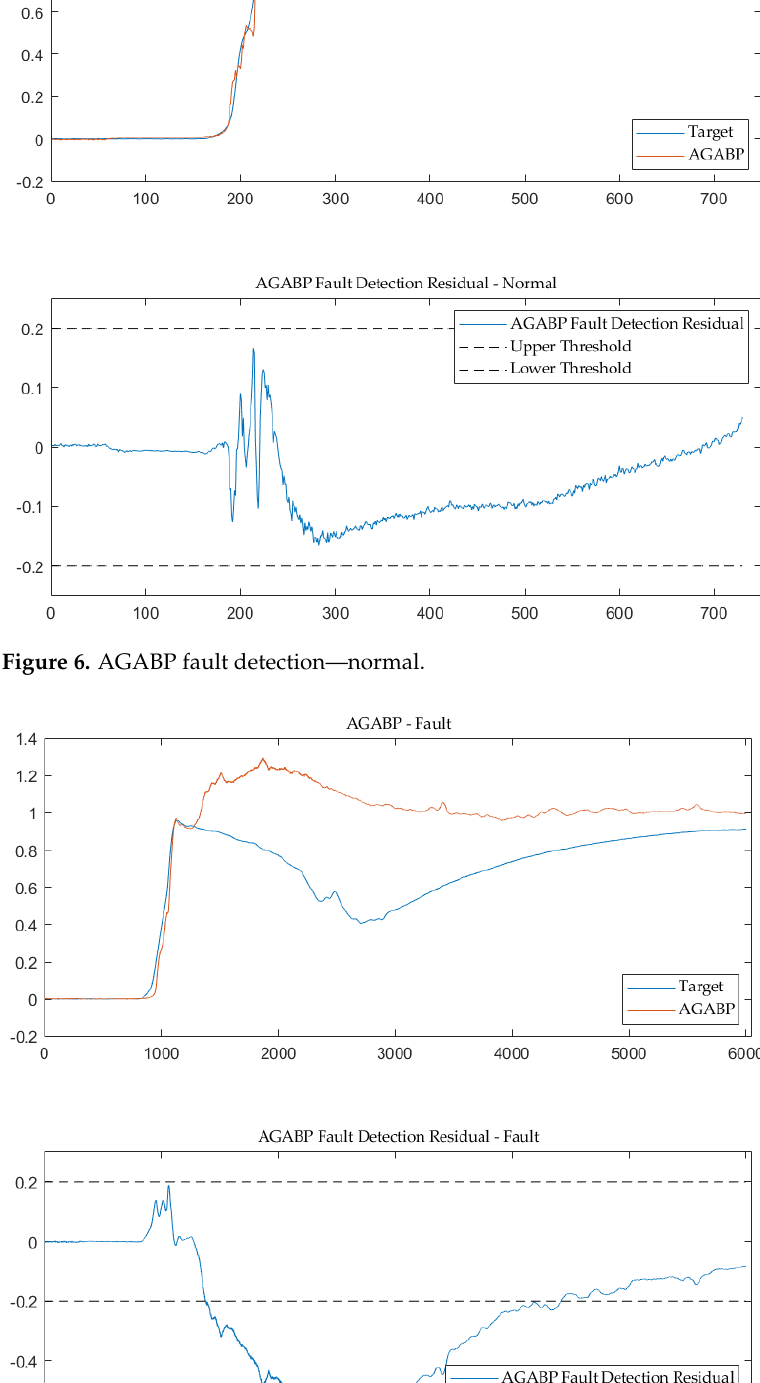
Figure 7. AGABP fault detection—fault. 5.2. Simulation Result and Analysis In order to evaluate the model proposed in this paper, this paper uses both the BP neural network and the standard GA to optimize the BP neural network to diagnose the faults of the same LH2/LOX rocket engine. In this paper, we ensure that the training pa- rameters of all BP networks are consistent, while for the GABP model, the crossover prob- ability is set to 0.9 and the mutation probability is set to 0.1, which is consistent with the maximum crossover probability and maximum variation probability of the AGABP model. In order to evaluate the quality of each model, the following standards are used as test indicators: